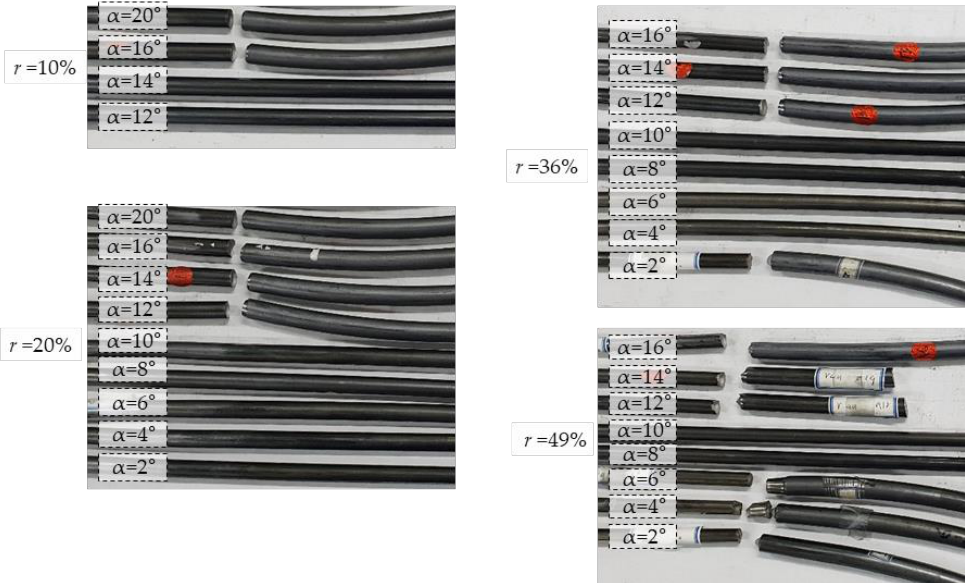
Figure 2. Fractured and non-fractured specimens for various r and α combinations. Thirteen specimens were not fractured, while sixteen specimens were fractured.